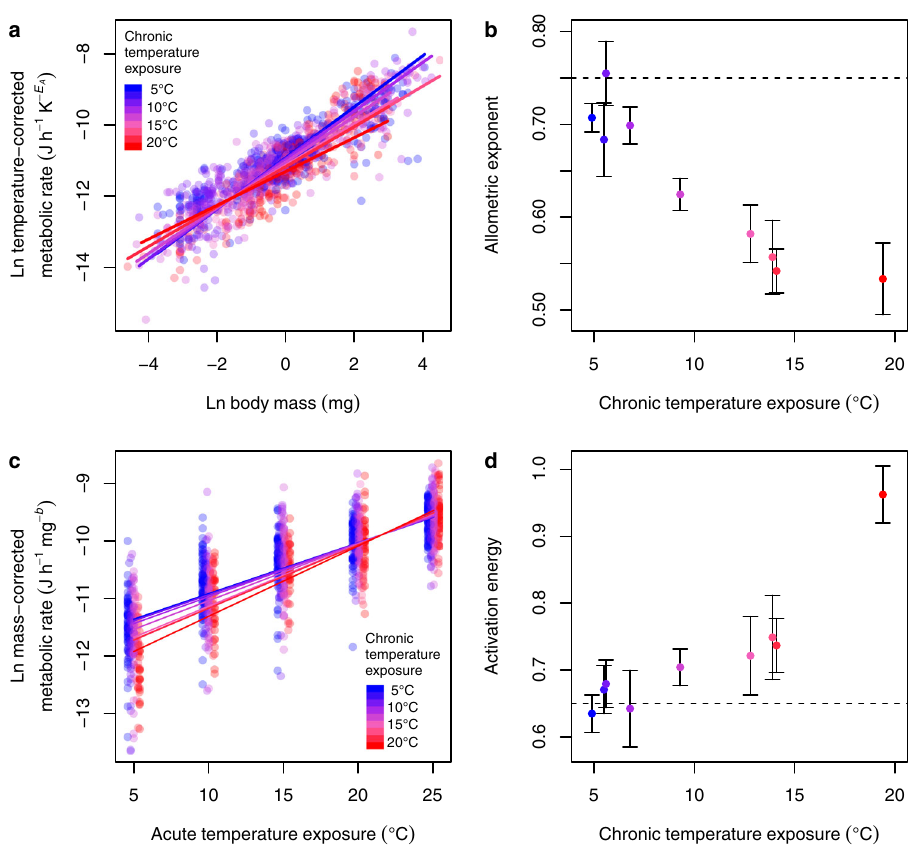
Fig. 1 Chronic exposure to warmer conditions alters the size- and temperature-dependence of metabolic rate. a Temperature-corrected metabolic rates are elevated for smaller organisms and suppressed for larger organisms after chronic exposure to warmer conditions, seen as ( b ) a decline in their allometric scaling exponent. The dashed line is the three-quarter scaling expected from MTE. c Mass-corrected metabolic rates are suppressed at lower acute temperatures and elevated at higher acute temperatures after chronic exposure to warmer conditions, seen as ( d ) an increase in their activation energy (thermal sensitivity). The dashed line is the typical activation energy of 0.65 eV expected from MTE for heterotrophic metabolism. The bars in ( b ) and ( d ) represent standard error around the mean from partial residual analysis of linear mixed-effects models fi tted in ( a ) and ( c ), respectively (see Table 1a for model parameters and the Supplementary Note for underlying R code). Colours of points and lines in all panels indicate the environmental temperature to which species have been chronically exposed (see graphical legends). Source data are provided as a Source Data fi